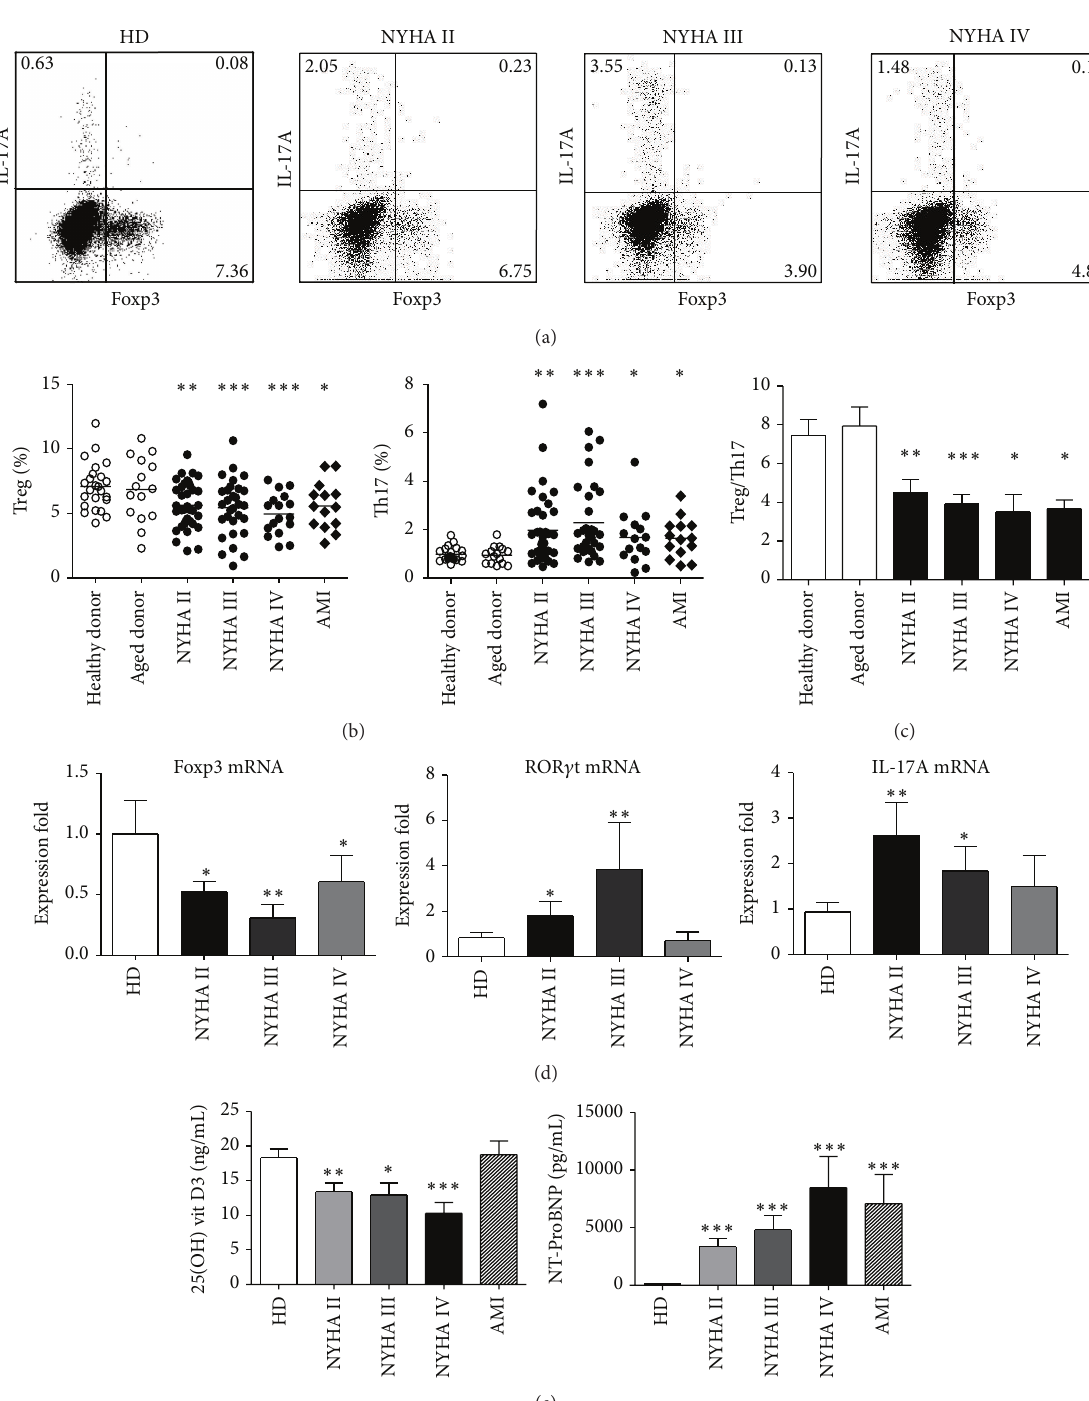
Figure 1: The imbalance of Treg and Th17 cells in patients with CHF. (a) Representative flow cytometric (FCM) dot plots of Foxp3 and IL-17 double staining in CD4 + T cell. (b) The increased frequencies of Th17 cells and decreased Treg cells were found in CHF patient compared to the healthy donor significantly, while AMI was set as other cardiovascular diseases. (c) The ratio of Treg to Th17 is significantly reduced in CHF. (d) The mRNA expressions of Treg and Th17 related transcription factors and cytokines. (e) Plasma concentrations of 25(OH)D and NT-ProBNP in three CHF groups and controls. Data represent the mean ± SEM; * 𝑃 < 0.05 , ** 𝑃 < 0.01 , and *** 𝑃 < 0.001 , as compared with